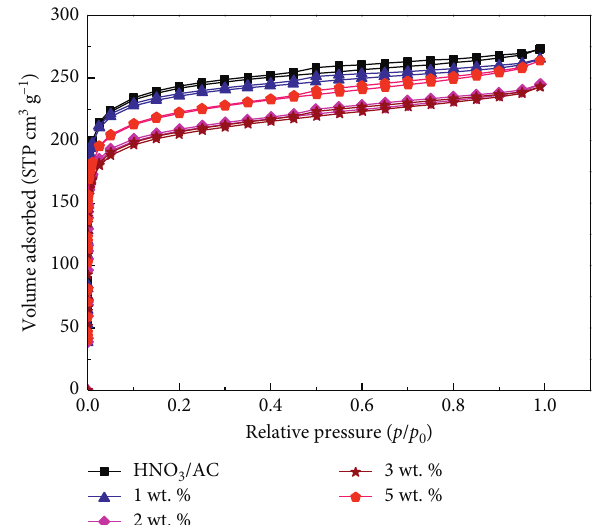
Figure 2: Nitrogen adsorption isotherm plots of adsorbents with different Mn-loaded